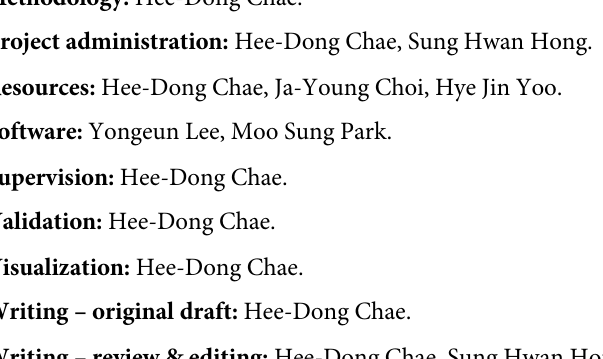
S1 Table. Interobserver agreements between human